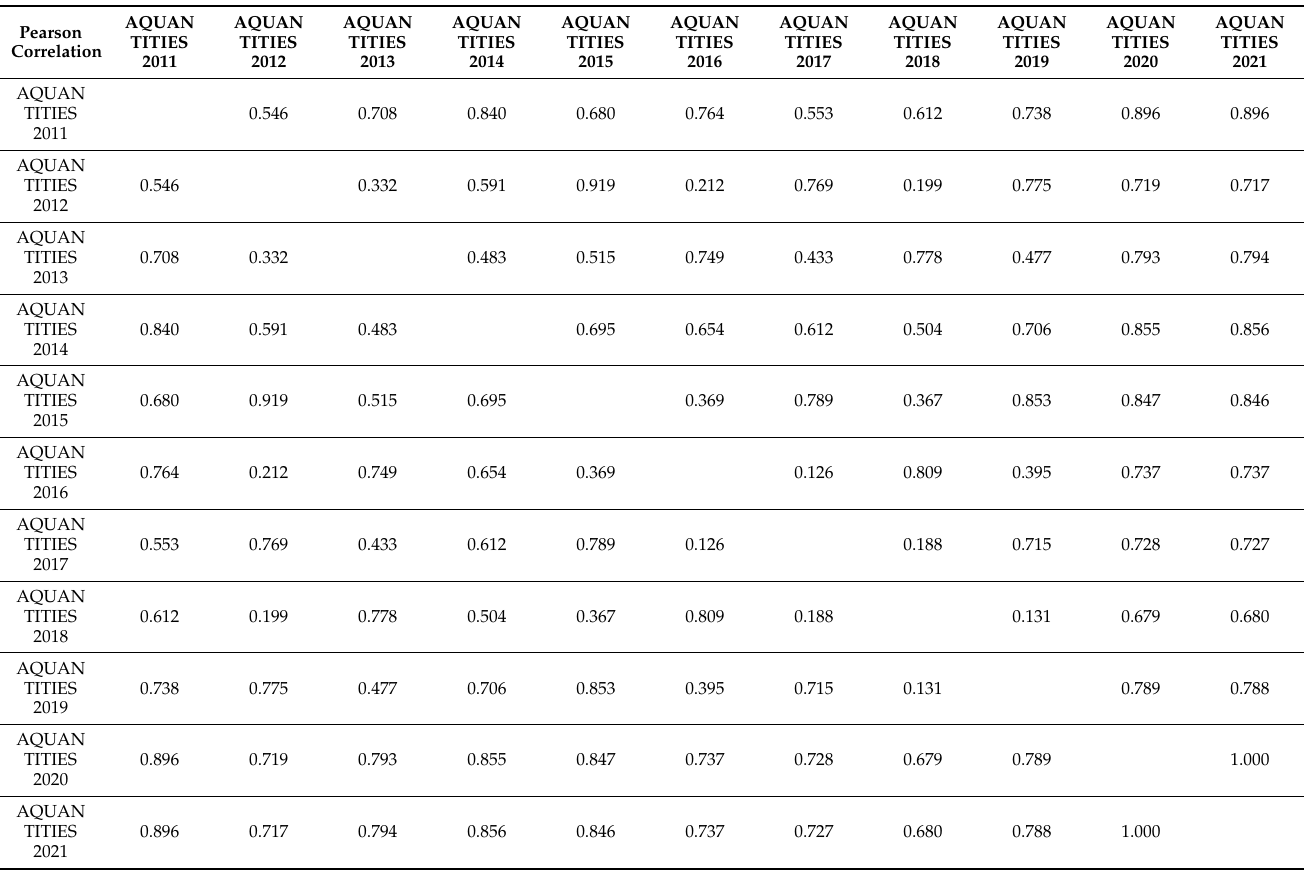
Table A5. Pearson correlation rates in dynamics for the unit value statistics for agricultural products indicator.